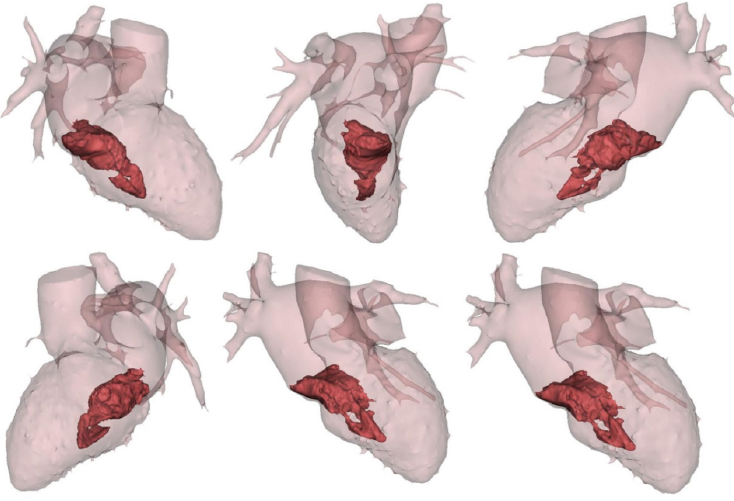
Fig. 2 – CT-based 3D virtual reconstruction of the mass performed using MIMICS software showing the extremely irregular borders and a narrow implantation stalk in the fossa